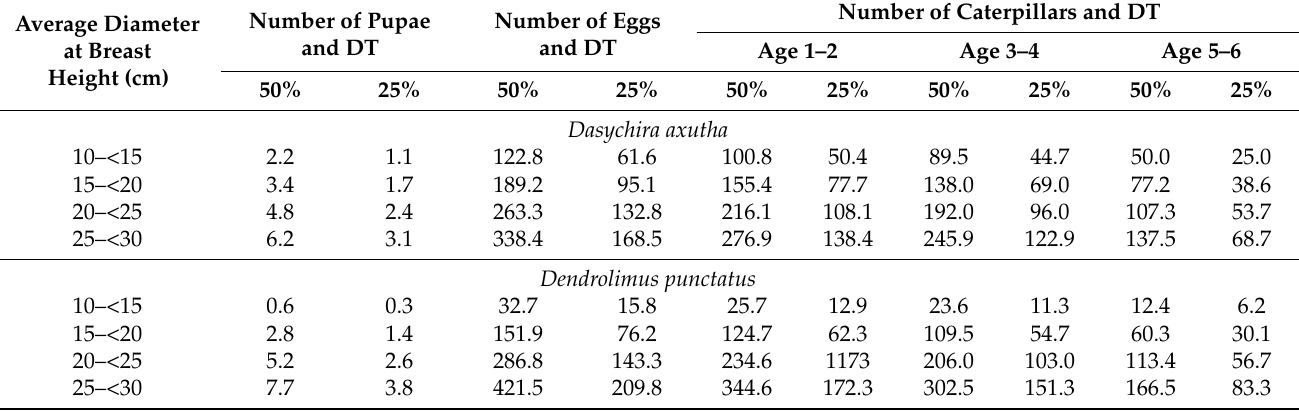
Table 7. Average number of pupae, eggs and caterpillars per tree and the damage threshold according to the average diameter at breast height. Average